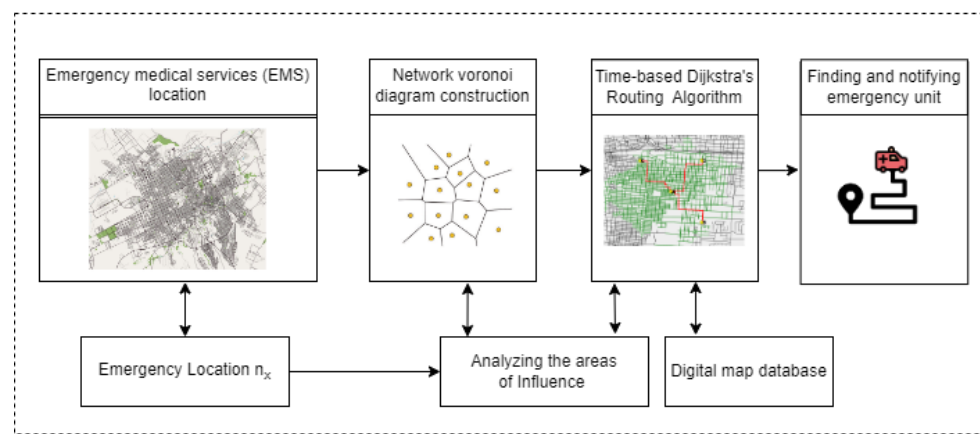
Figure 3. Proposed system architecture.